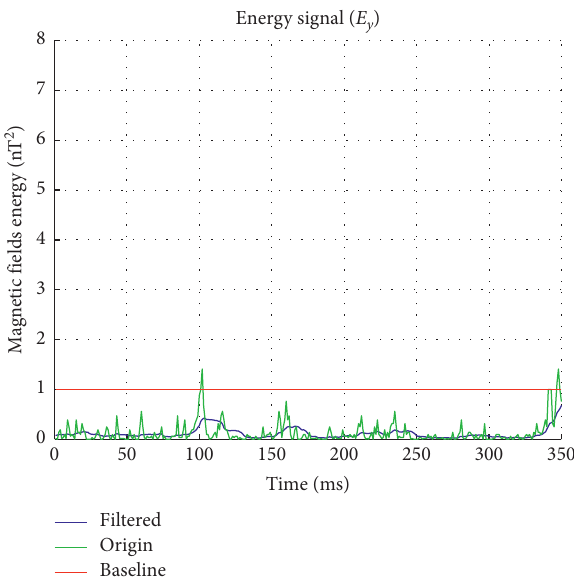
Figure 5: The magnetic field energy signal when no vehicle is passing by, filtered by MAF-2.